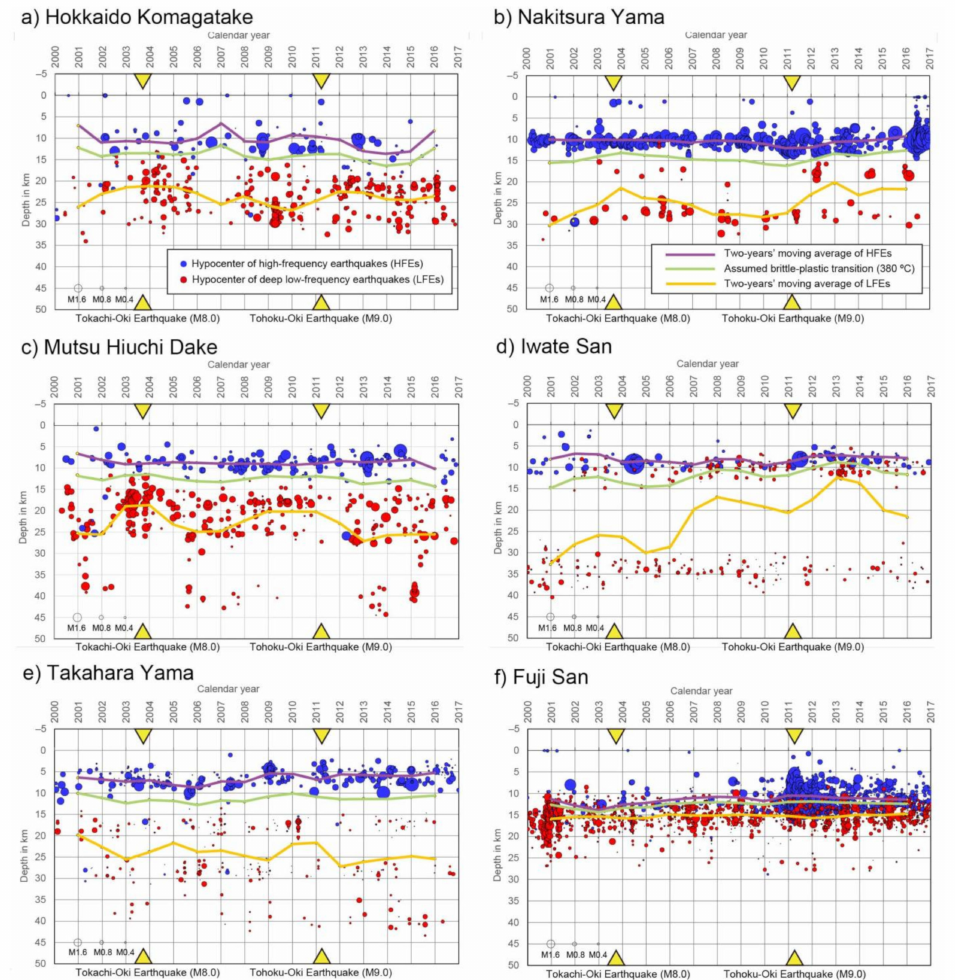
Figure 3. Chronological variations of the hypocenter depth of the deep low-frequency earthquakes (LFEs) and ordinary high-frequency earthquakes (HFEs) in the six volcanic fields, ( a ) Hokkaido Komagatake, ( b ) Nakitsura Yama, ( c ) Mutsu Hiuchi Dake, ( d ) Iwate San, ( e ) Takahara Yama, and ( f ) Fuji